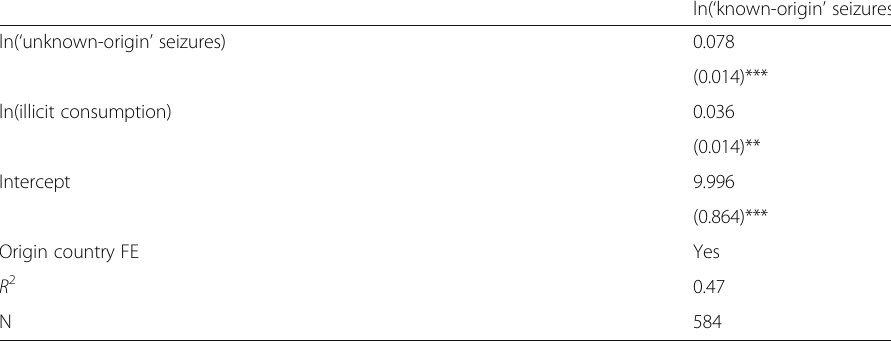
ln( ‘ known-origin ’ seizures)